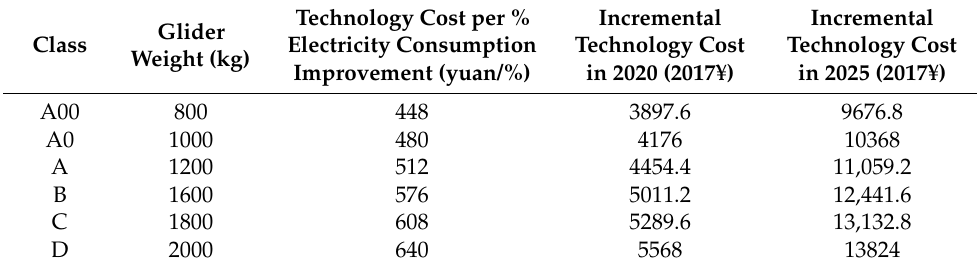
Table 1. The incremental energy-saving technology costs for different